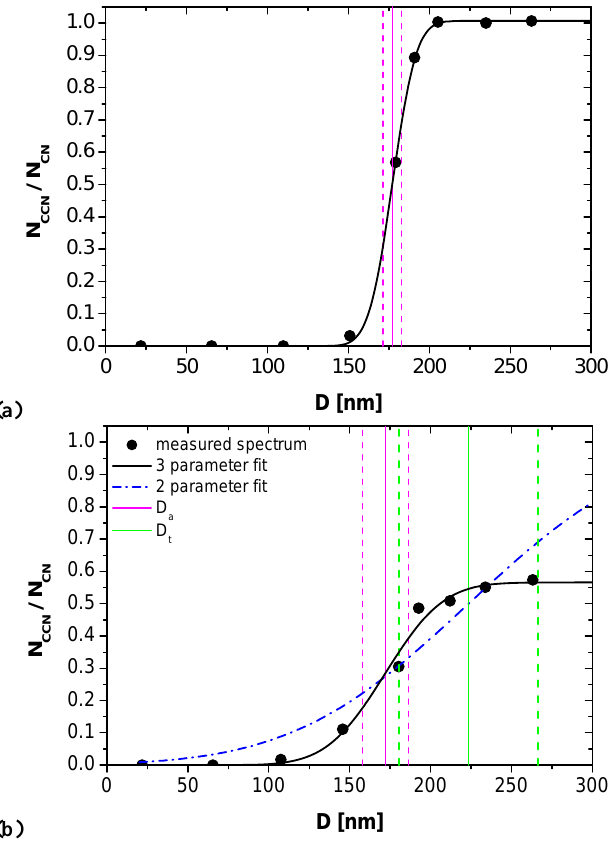
Fig. 2. Exemplary CCN efficiency spectra (a) with “ideal” shape (12 July 2006, 18:55–19:06), and (b) with low maximum fraction of activated particles (9 July 2006, 03:23–03:34): measurement data points (corrected according to Sect. 2.2.3; black dots); 3-parameter CDF fit (black solid line) with fit parameters D a (pink line), and σ a (distance between pink dashed lines); 2-parameter CDF fit (blue dash-dotted line) with fit parameters D t (green line) and σ t (distance between green dashed